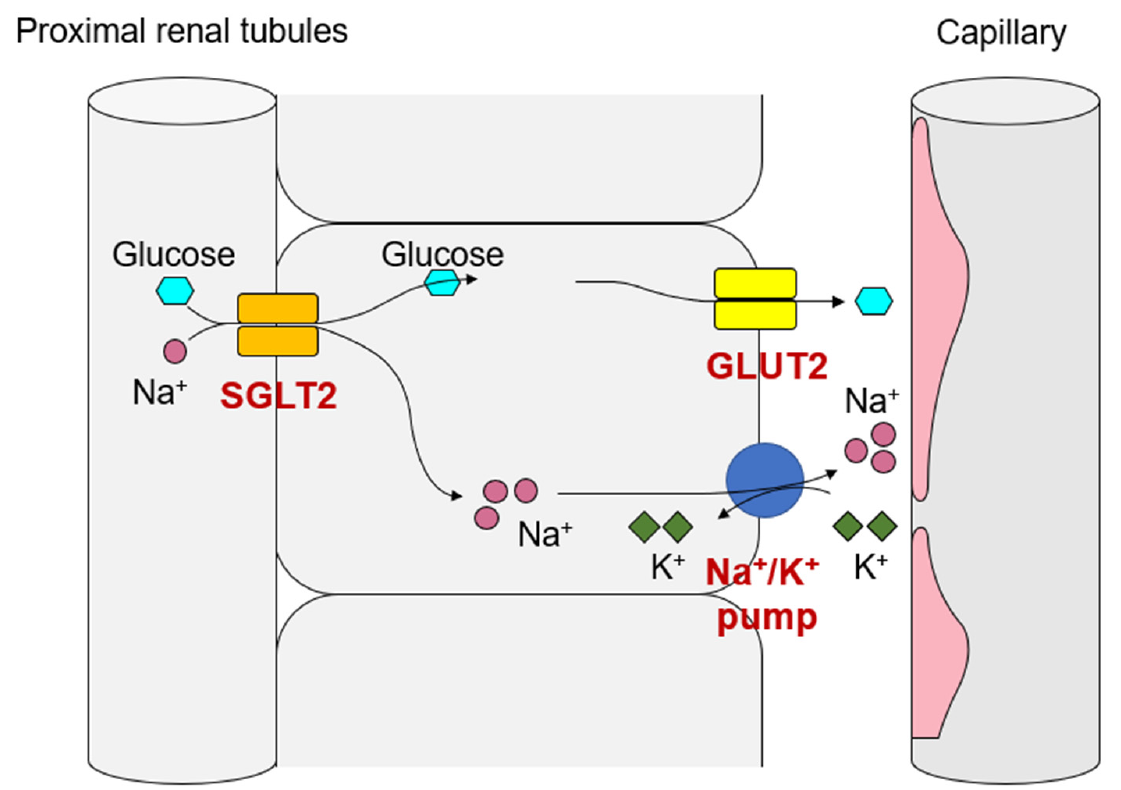
Figure 1. Sodium-glucose co-transporter 2 (SGLT2)-mediated Na + /glucose uptake into renal proxi- mal tubular epithelial cells is coupled with Na + /K pump activity. The energy balance shifts dynami- cally after SGLT2 inhibitor administration. Thus, in diabetes and heart failure, where SGLT2 activity is chronically increased, renal proximal tubular epithelial cells acquire inflammatory traits due to metabolic stress.